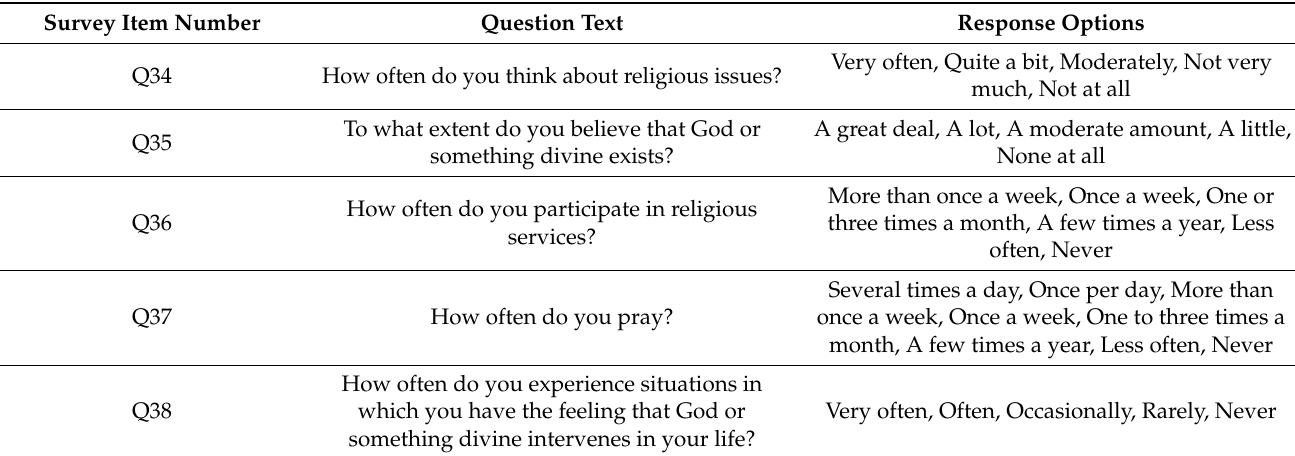
Table 2. Religiosity survey